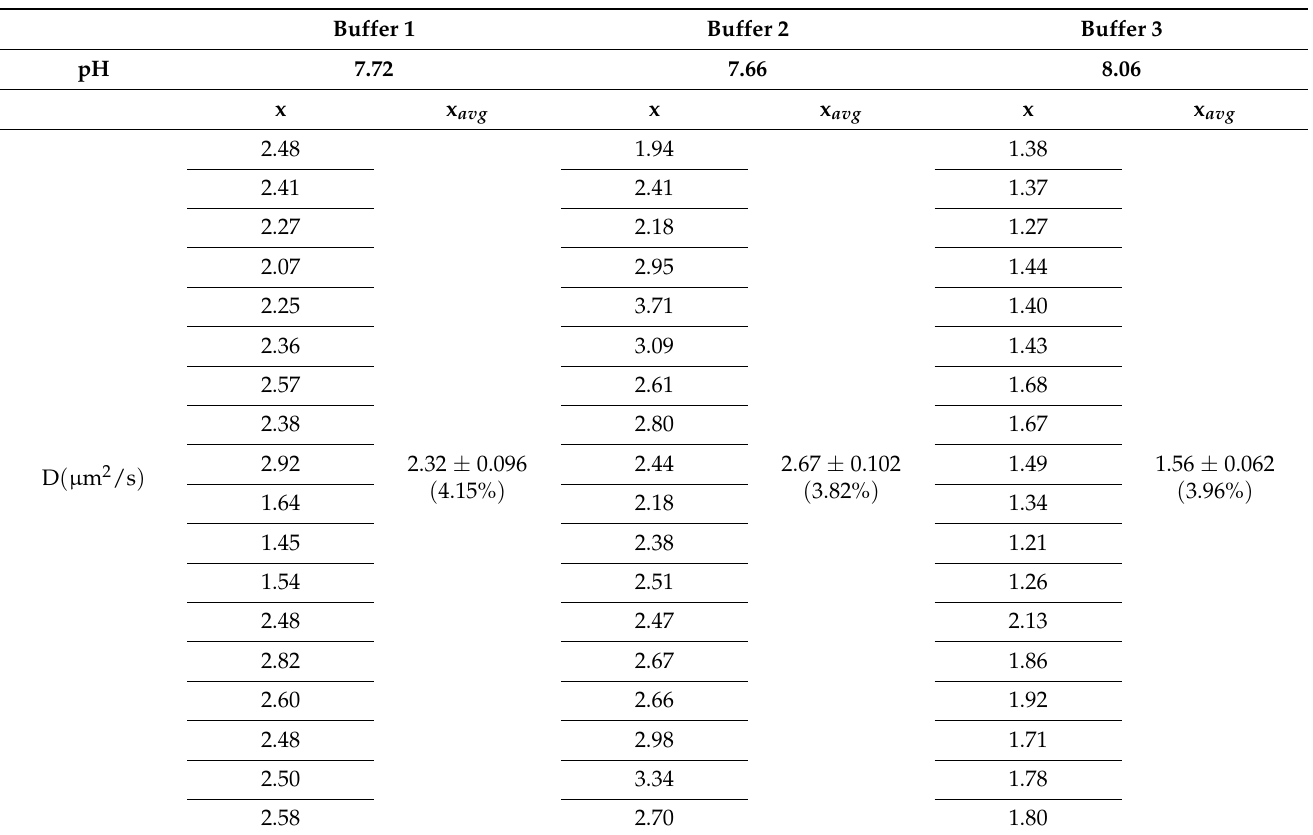
Table 4. Experimental translational diffusion coefficient (D) values for buffers 1, 2, and 3. For each buffer, we enlisted the 18 measured diffusion coefficient values in the first column, while the mean value, the uncertainty (standard deviation of the mean value) [36], and percentage error are provided in the second column.